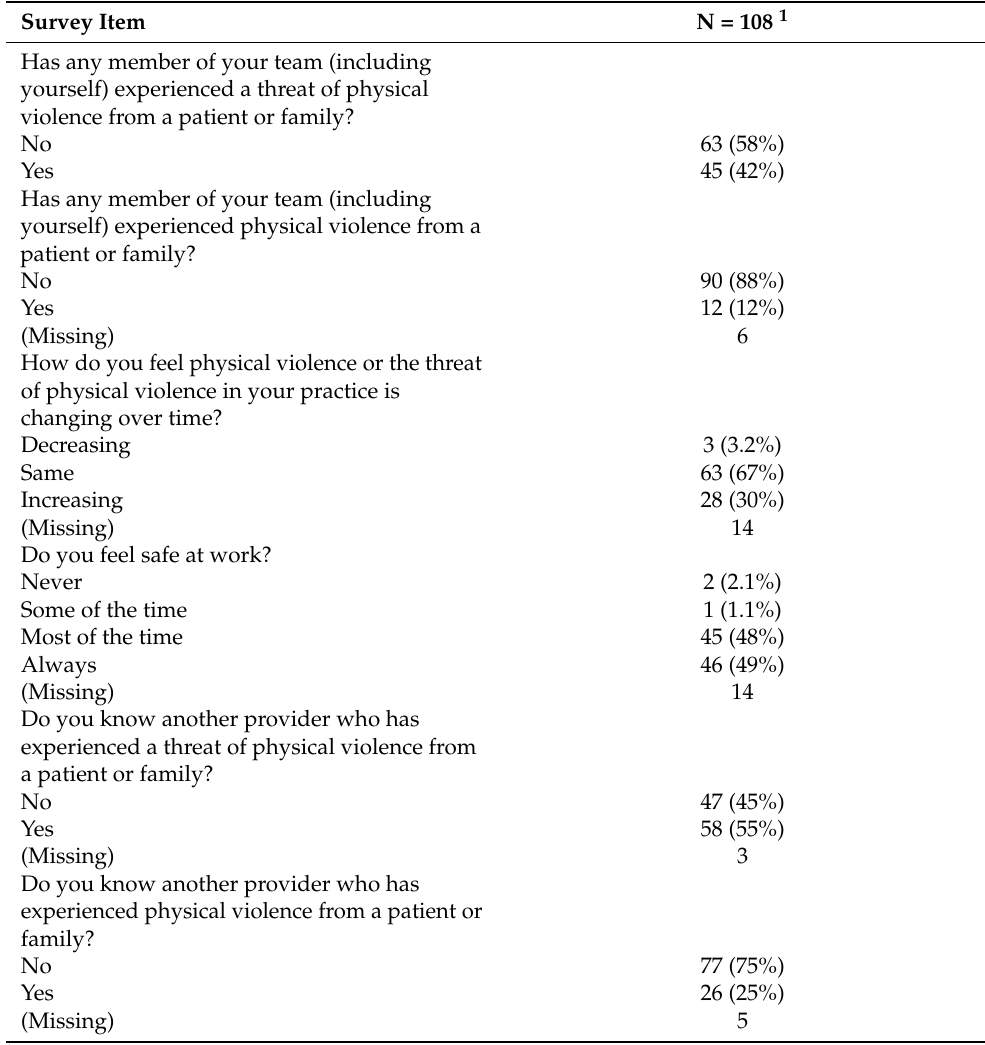
Table 2. Prevalence of Violence in Heart and Lung Transplantation